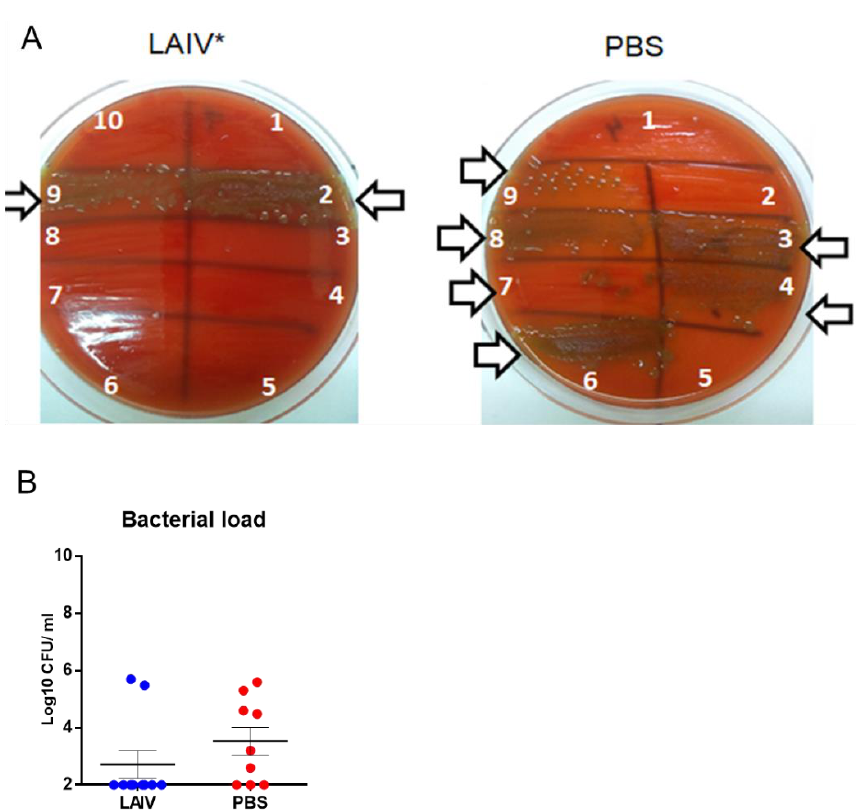
Figure 7. The results of the assessment of bacteriemia in infected animals on day 5, following bacterial superinfection. The mice were challenged using A/South Africa/3626/2013(H1N1) pdm09 influenza virus followed by S. pneumoniae infection 3 days apart. ( A ) Counting the number of bacteria in the blood of LAIV-immunized and mock-immunized mice. Arrows indicate pneumococcal colonies. The white numbers denote each of the mice. * p = 0.02 compared to PBS group (Fisher’s exact test). ( B ) Assessment of average bacterial-load levels in the blood. Blue and red dots mean individual bacterial titers (Log10 CFU/ml).